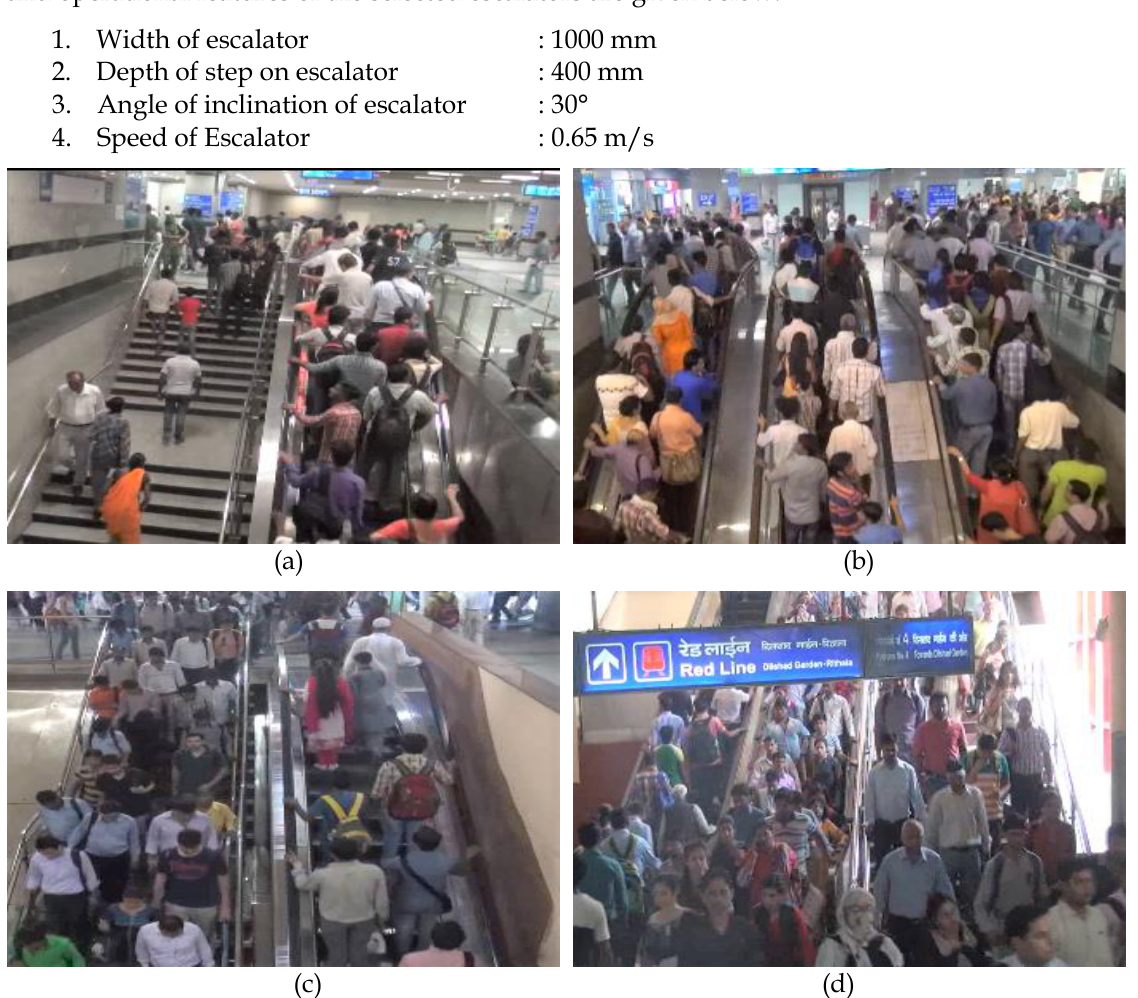
Figure 1. Selected Escalators at Metro Stations: (a) CSM Station; (b) RCM Station; (c) and (d) KGM